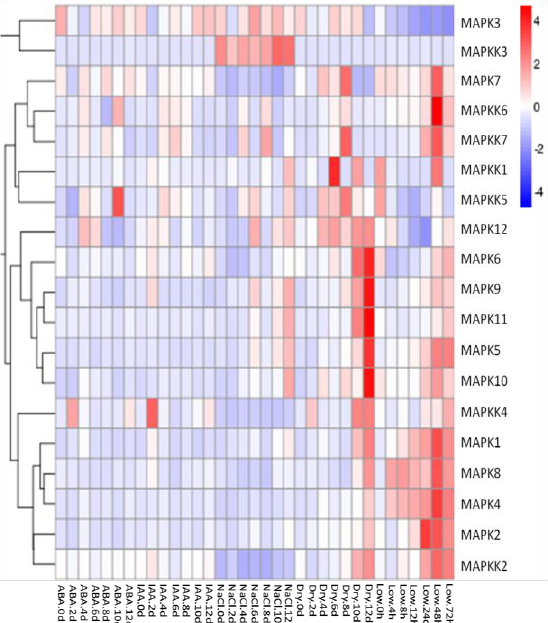
Figure 7. Expression patterns of FvMPK and FvMPKK genes after different stress and hormone treatments of leaves in Fragaria vesca . Leaves were harvested every two days (0, 2, 4, 6, 8, 10 and 12 days) after treatment: Abscisic acid (ABA) (100 μM), indole-3-acetic acid (IAA) (100 μM), NaCl (100 mM) and drought treatments. Leaves from the low temperature treatment were collected at 0, 4, 8, 12, 24, 48 and 72 h after cold stress application.